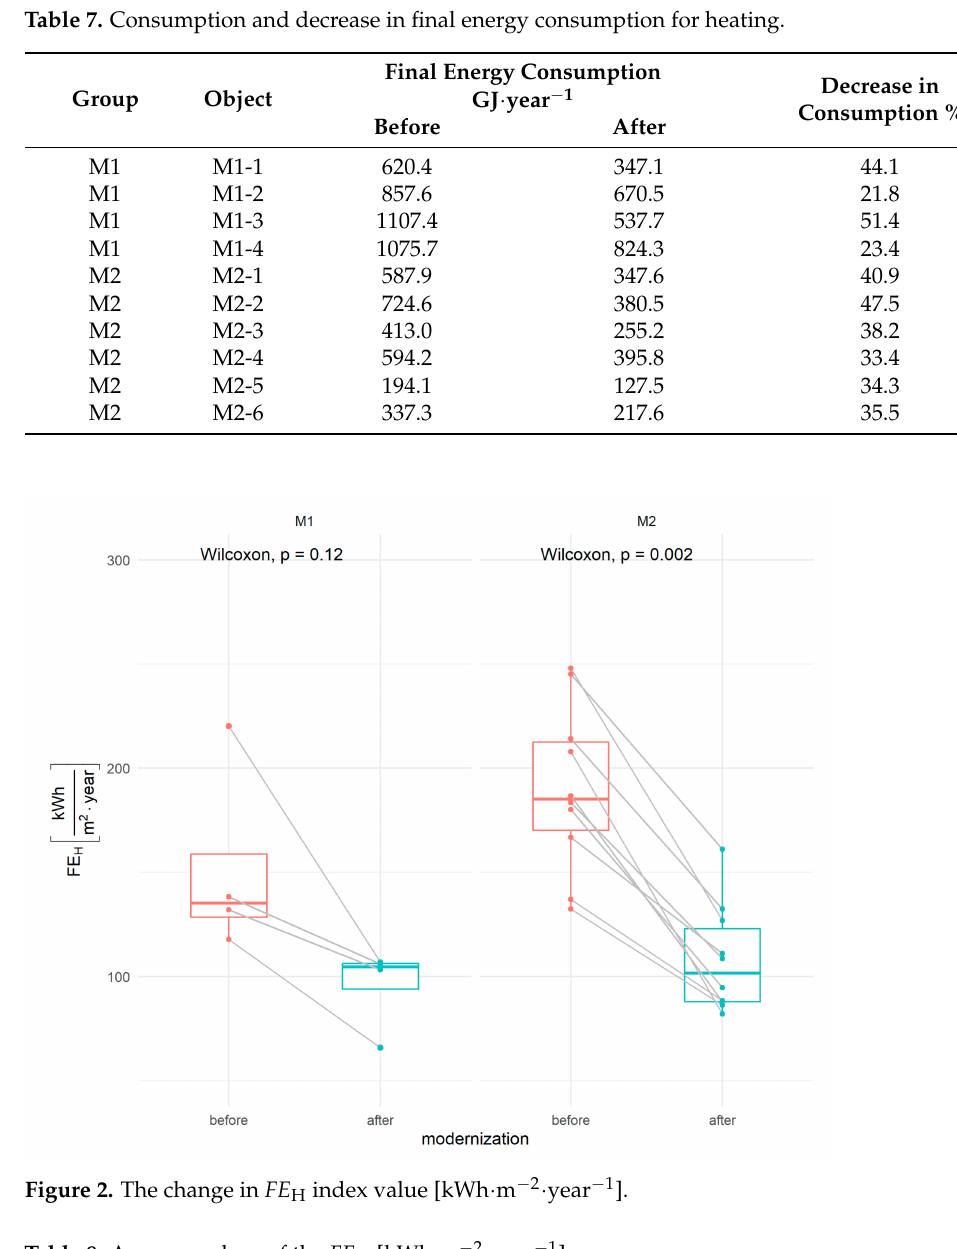
Table 8. Average values of the FE H [kWh · m − 2 · year − 1